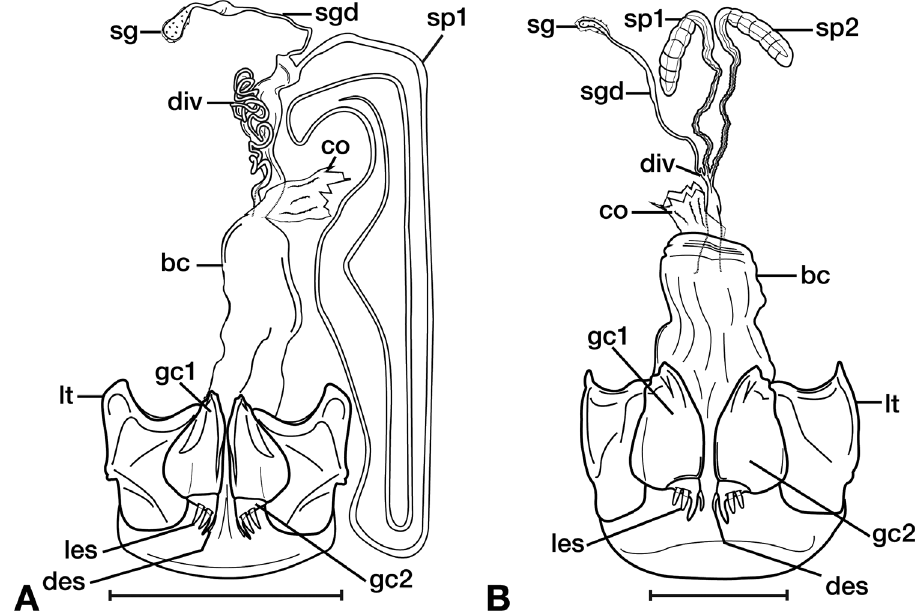
Figure 15. Line drawings of the female reproductive tract, ventral aspect, of A Bellavalentis kuzugamii (Shibata) B Brachichila hypocrita Chaudoir. Legend: bc bursa copulatrix; co common oviduct; des dorsal ensiform setae; div diverticulum gc1 gonocoxite 1; gc2 gonocoxite 2; les lateral ensiform setae; lt lateral tergite; sg spermathecal gland; sgd spermathecal gland duct; sp1 spermatheca 1; sp2 spermatheca 2. Scale bars: 0.5